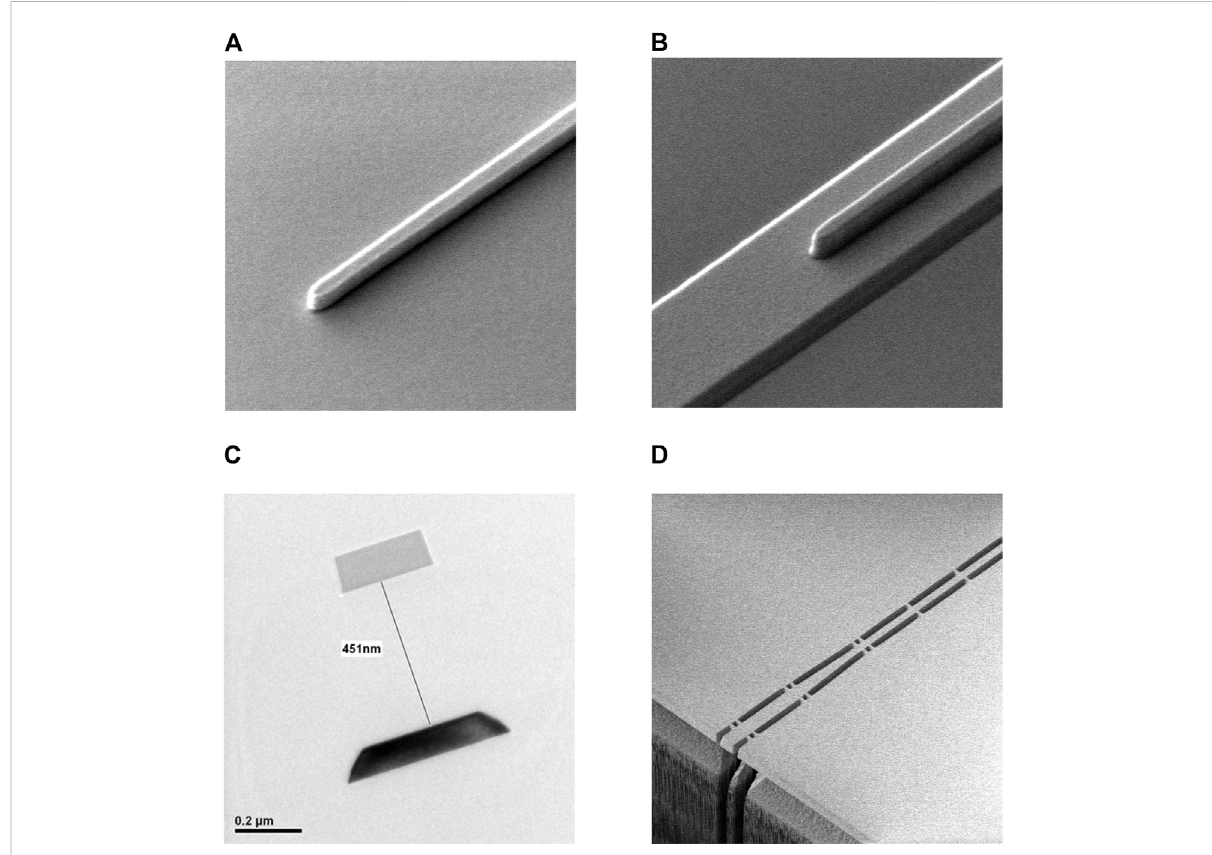
FIGURE 6 (A) SEMimageofthetapertipofthec-Sislablayer, (B) SEMimageofthetransitionfromthec-Sislablayertoc-Sichannellayer, (C) TEMimageof the double-layer waveguides cross-section, (D) SEM image of the cantilevered structure